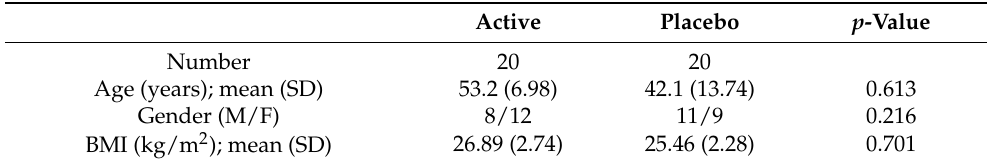
Table 2. Baseline demographic